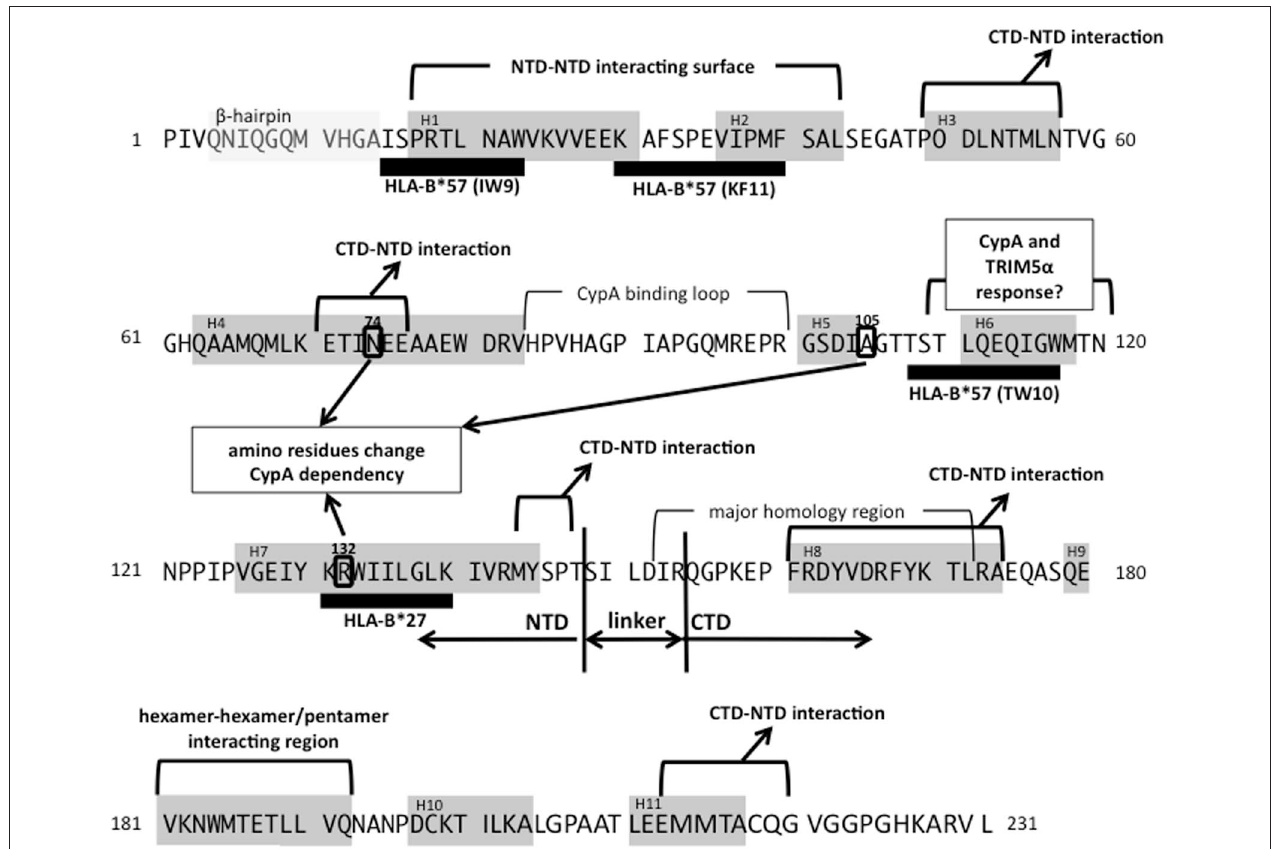
FIGURE 2 | MappingofCA functionaldomainsandtwomajorprotective CTLalleles. Gray boxesshow β -hairpin (aminoacids 4–14)orhelixstructures (H1–H11).ThickblackbarsindicatetheCTLepitopesrestrictedbyeachallele(Llano etal.,2009).TheNTD-NTD,CTD-NTD,orhexamer-hexamer/pentamerinteracting